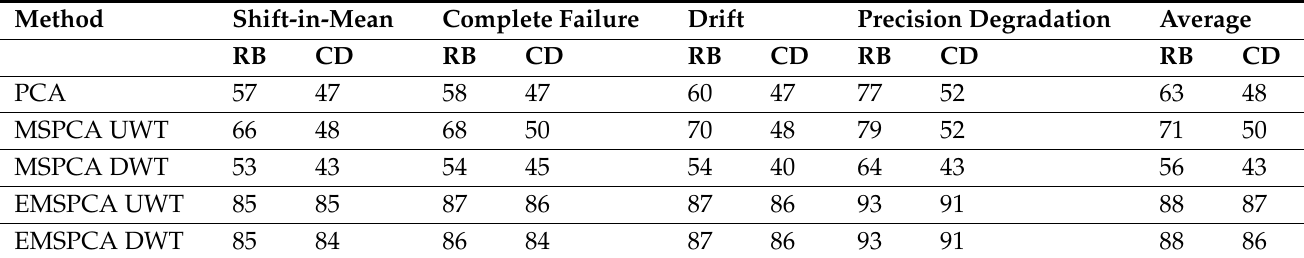
Table 4. CSTR Sensor Fault Isolation Monte Carlo Simualtion Results (Of Those Detected).